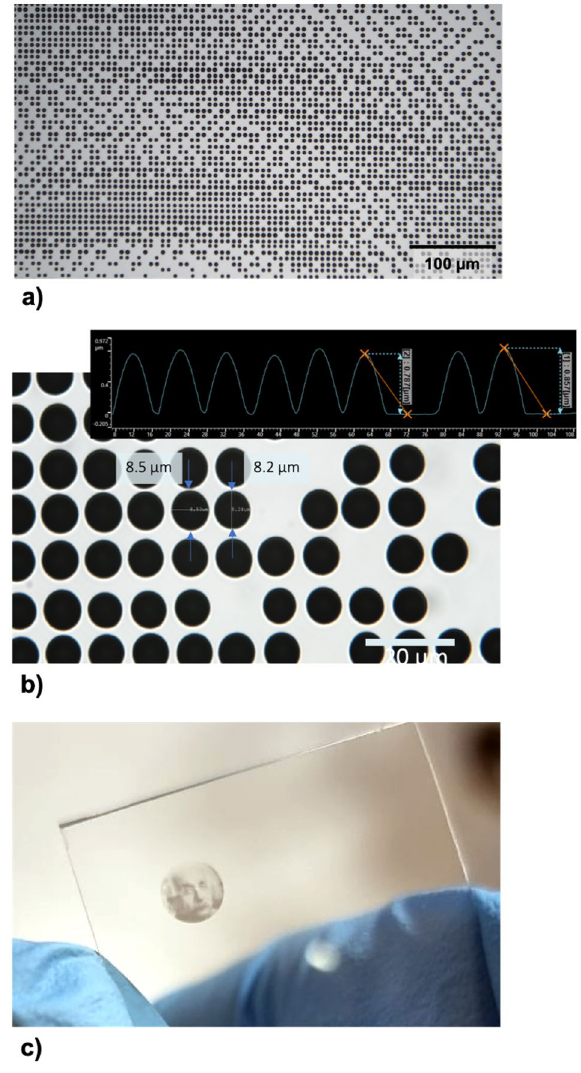
Figure 13. ( a ) Microdots printed using the UPD approach, the bar denotes 100 μm; ( b ) higher magnification of the sample, the bar denotes 20 μm and the inset shows cross section of the dots profile obtained using a profilometer; ( c ) an example of high-resolution picture consisting of microdots printed using the UPD